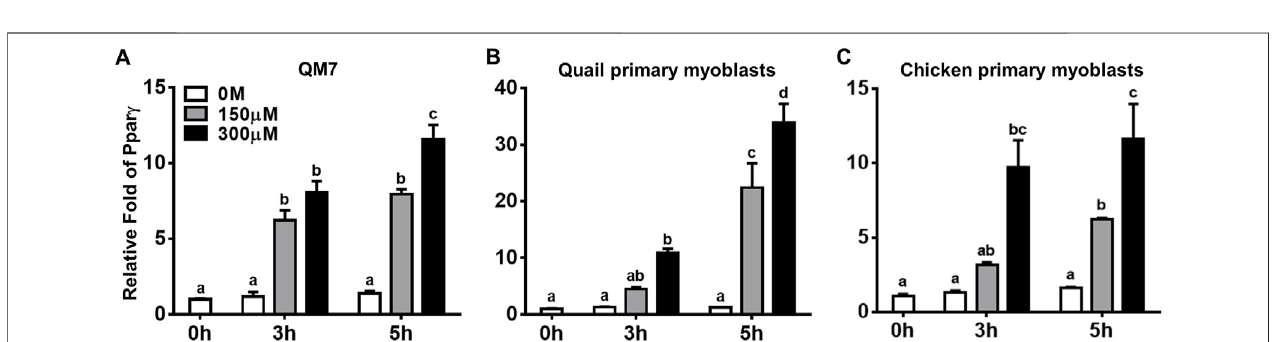
FIGURE 4 | Regulation of Ppar γ expression by atRA in myoblasts. Expression levels of Ppar γ in QM7 cells (A) , and primary myoblasts from quail (B) and chickens (C) weremeasuredat0,3,5 haftersupplementingdifferentconcentrationsofatRA(0 M,150 μ M,or300 μ M)in10%CS.Gapdhwasusedasahousekeepinggeneand all expression levels ofPpar γ were normalized bythelevels ofeach groupat 0 h. All datawere shown asmean±SEM ( n =3from 3independent experiments).One-way ANOVA followed by Tukey ’ s multiple comparison test was used for statistical analysis by the GraphPad PRISM program. (A-D) indicates statements of signi fi cance, p <